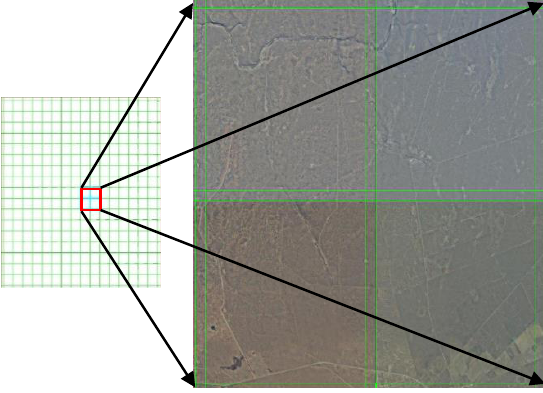
Fig.8.3 Four images of the mosaic dataset before color balance.